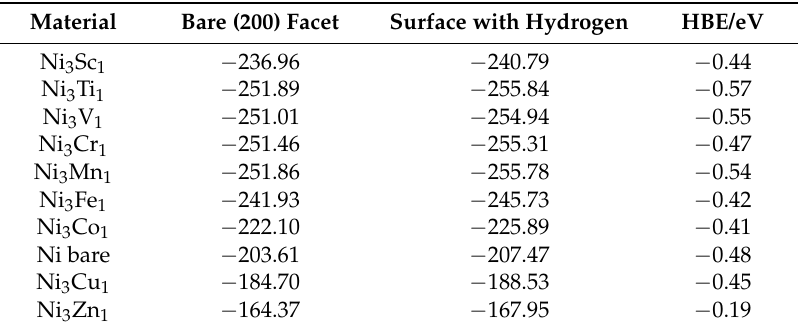
Table A2. Ground state energies of bare and with hydrogen at (200) facet (1/8 ML) supercell 2 × 2 × 1 and calculated HBE (all energies are in eVs).